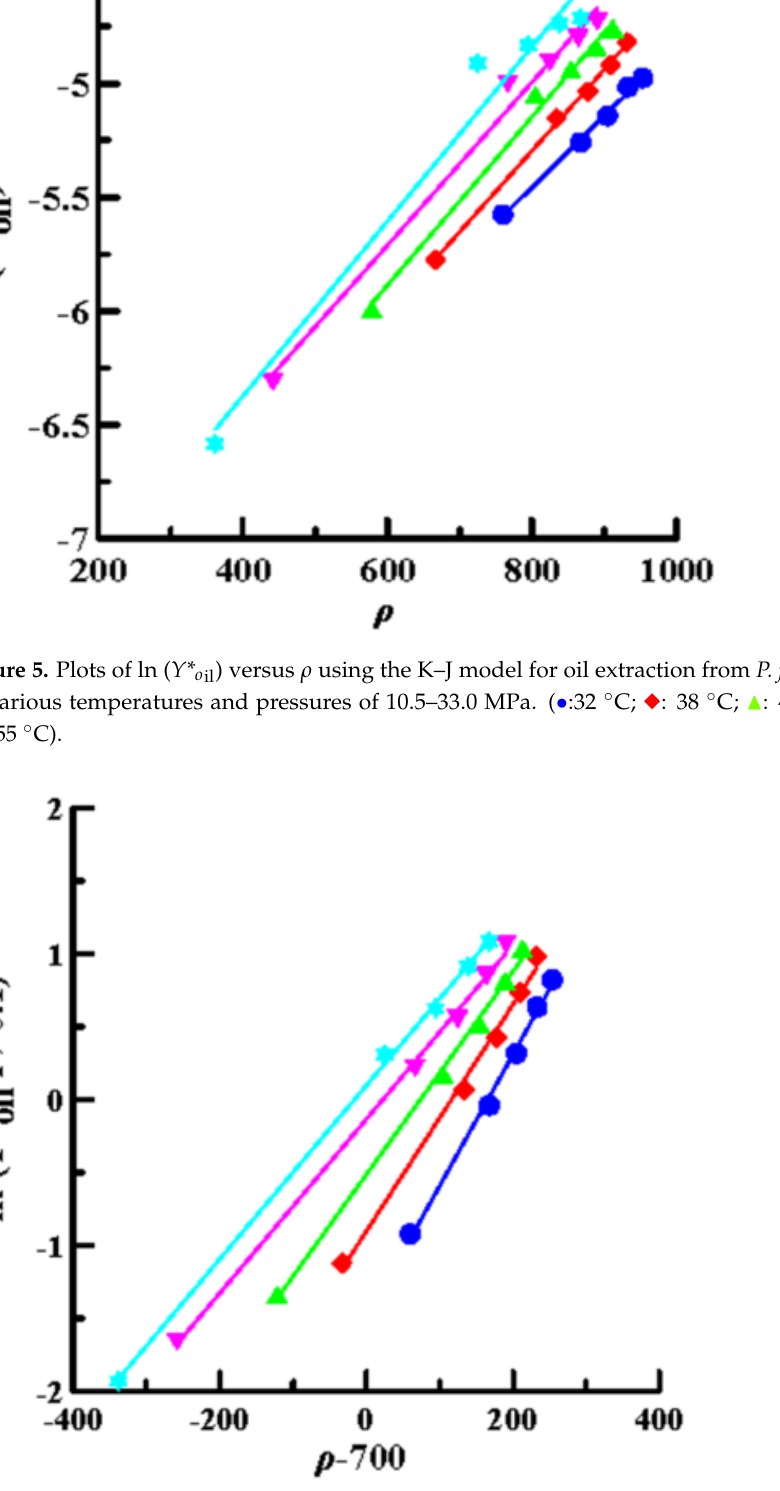
Figure 6. Plots of ln ( Y * oil P /0.1) versus ( ρ –700) using the Bartle model for oil extraction from P. frutescens leaves at various temperatures and pressures of 10.5–33.0 MPa. ( • :32 ◦ C; (cid:117) : 38 ◦ C; (cid:78) : 43 ◦ C; (cid:72) : 49 ◦ C; (cid:70) : 55 ◦